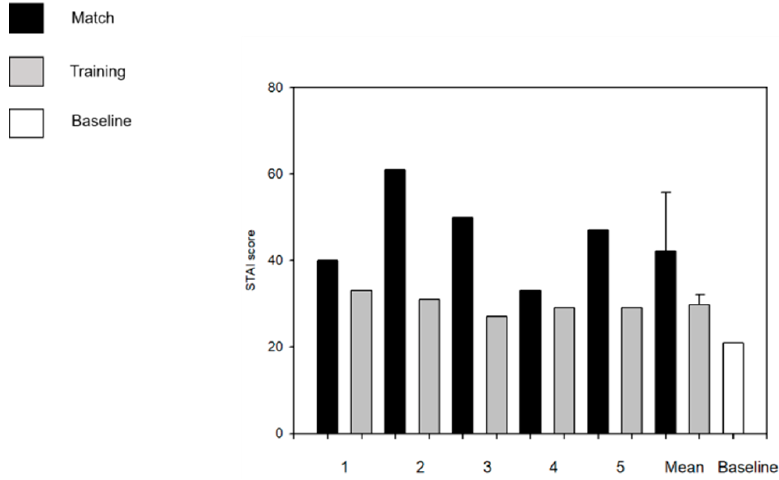
Figure 5. State-Trait Anxiety Inventory (STAI) values collected on five different matches, five different trainings, and at the baseline day.